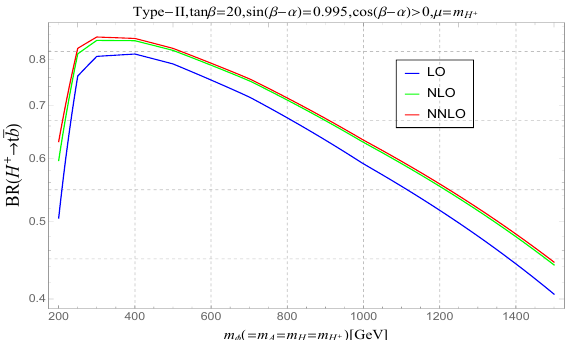
Figure 7. Branching ratio of the charged Higgs boson decay into t ¯ b in the 2HDM of Type-II, using the LO(Blue), NLO(Green) and NNLO(Red) partial width with tan β = 20 , sin( β − α ) = 0 . 995 and cos( β − α ) > 0 .